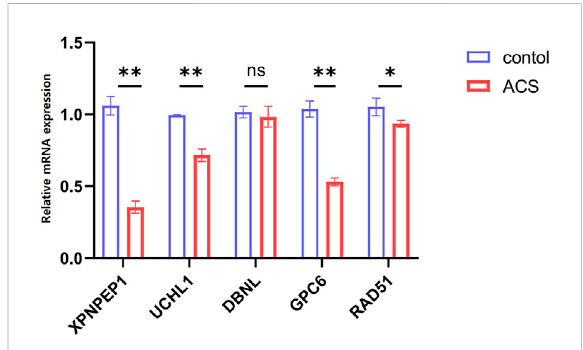
FIGURE 7 Theexpressionlevels of fi vehubgenesintheceRNA network